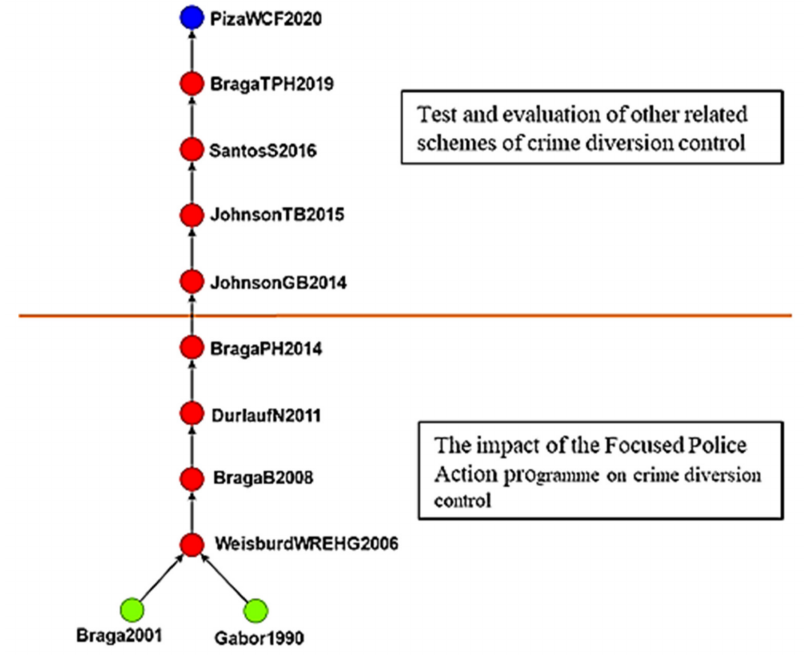
Figure 6. Global main path analysis of first cluster. (Top to bottom). Assessing crime displacement control and other programs; the effects of focused police action programs on crime displacement control. Figure 5 translation: (top row, left to right): research theme; first cluster (122